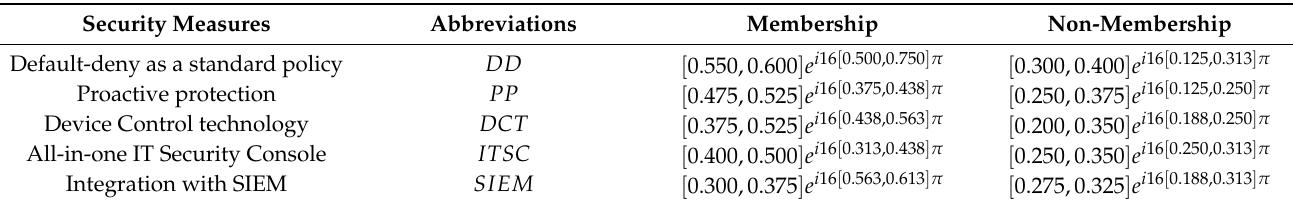
Table 1. Details of security